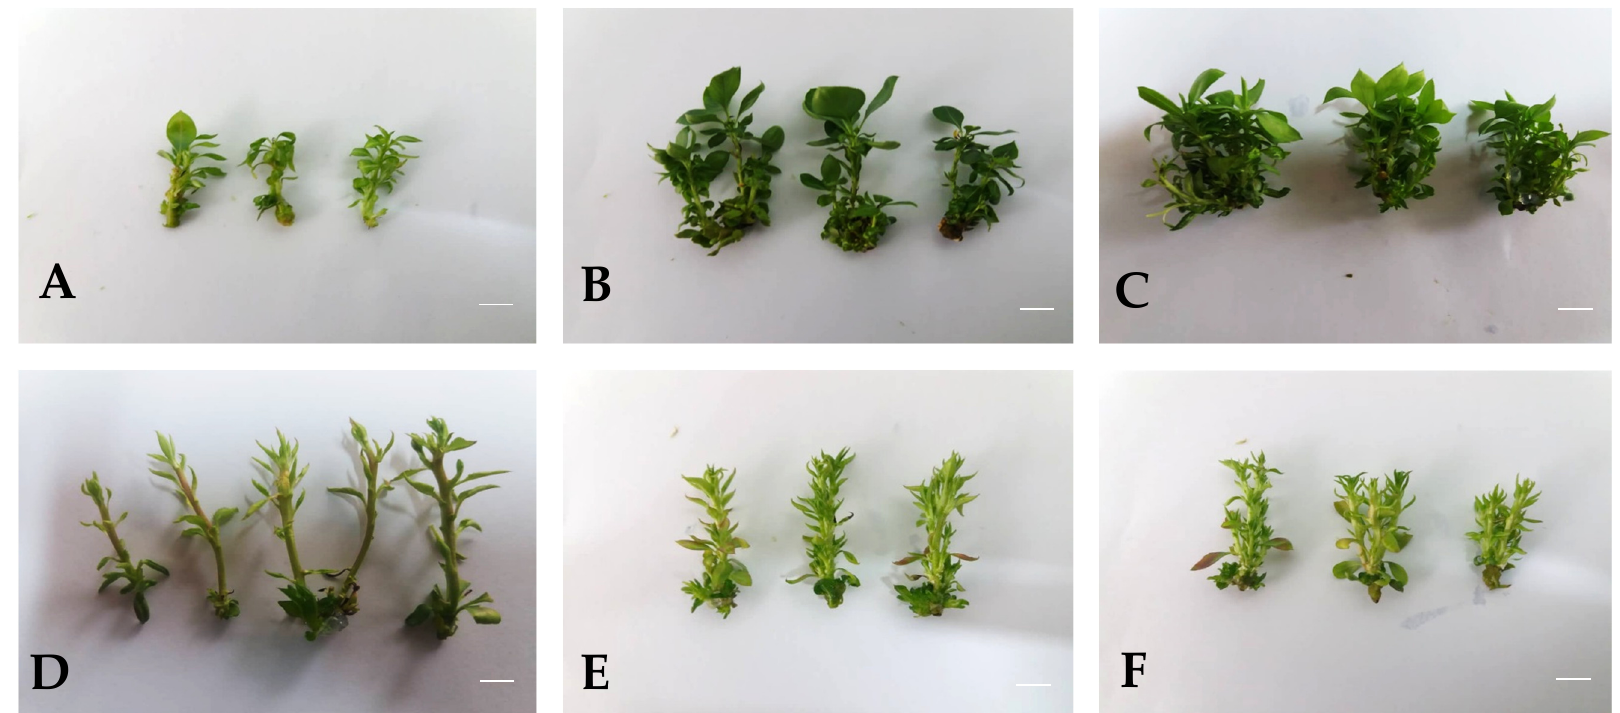
Figure 2. In vitro shoots of pear ( Pyrus communis L.) ‘Pyrodwarf ® (S)’ rootstock, after the last sub-culture. ( A ) Microshoots produced in the MS medium supple- Figure 2. In vitro root induction in pear ( Pyrus communis L.) ‘Pyrodwarf ® (S)’ rootstock. ( A ) Rooted microshoots in the MS medium with 0.5 mg · L − 1 IAA, ( B ) Rooted mented with 1 mg·L –1 BA, ( B ) Microshoots produced in the MS medium with 2 mg·L –1 BA and 0.5 mg·L –1 Kin, ( C ) Microshoots produced in the MS medium with microshoots in the MS medium with 1 mg · L − 1 IAA, ( C ) Rooted microshoots in the MS medium with 0.5 mg · L − 1 IBA, ( D ) Rooted microshoots in the MS medium 2 mg·L –1 BA and 1 mg·L –1 Kin, ( D ) Microshoots produced in the WPM medium with 1 mg·L –1 BA, ( E ) Microshoots produced in the WPM medium with 2 mg·L –1 with 1 mg · L − 1 IBA, ( E ) Hardening of plantlets in plastic dishes filled with perlite and cocopeat (in a ratio of 1:3) in the acclimatization room, ( F ) Plantlets transferred BA and 0.5 mg·L –1 Kin, ( F ) Microshoots produced in the WPM medium with 2 mg·L –1 BA and 1 mg·L –1 Kin. Scale bar = 10 mm. to plastic pots (after 20 days) for further acclimatization in the